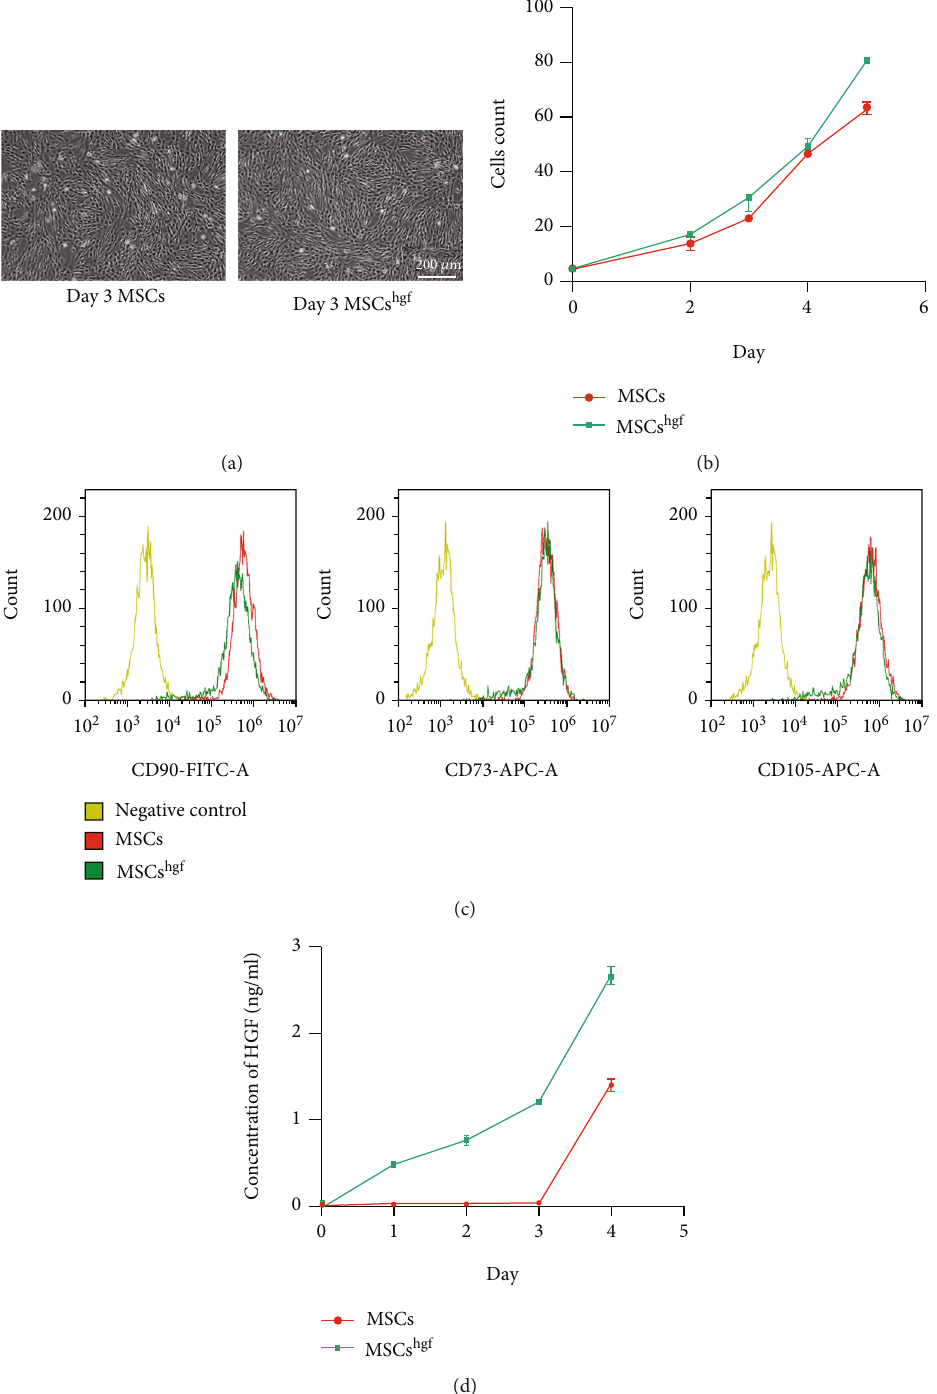
Figure 1: HGF gene-transfected MSCs (MSCs hgf in the legend) retain the characteristics of original MSCs and signi fi cantly increased the expression of the HGF gene in transfected MSCs. (a) Cell morphology of MSCs and HGF gene-transfected MSCs. (b) Cell count of MSCs and HGF gene-transfected MSCs ( n = 3 ) at 0, 2, 4, and 6 d. (c) Positive markers (CD73, CD90, and CD105) on the surface of mesenchymal stem cells were tested in MSCs and HGF gene-transfected MSCs. (d) Expression of HGF in MSCs and HGF gene- transfected MSCs ( P < 0 : 01 , n = 3